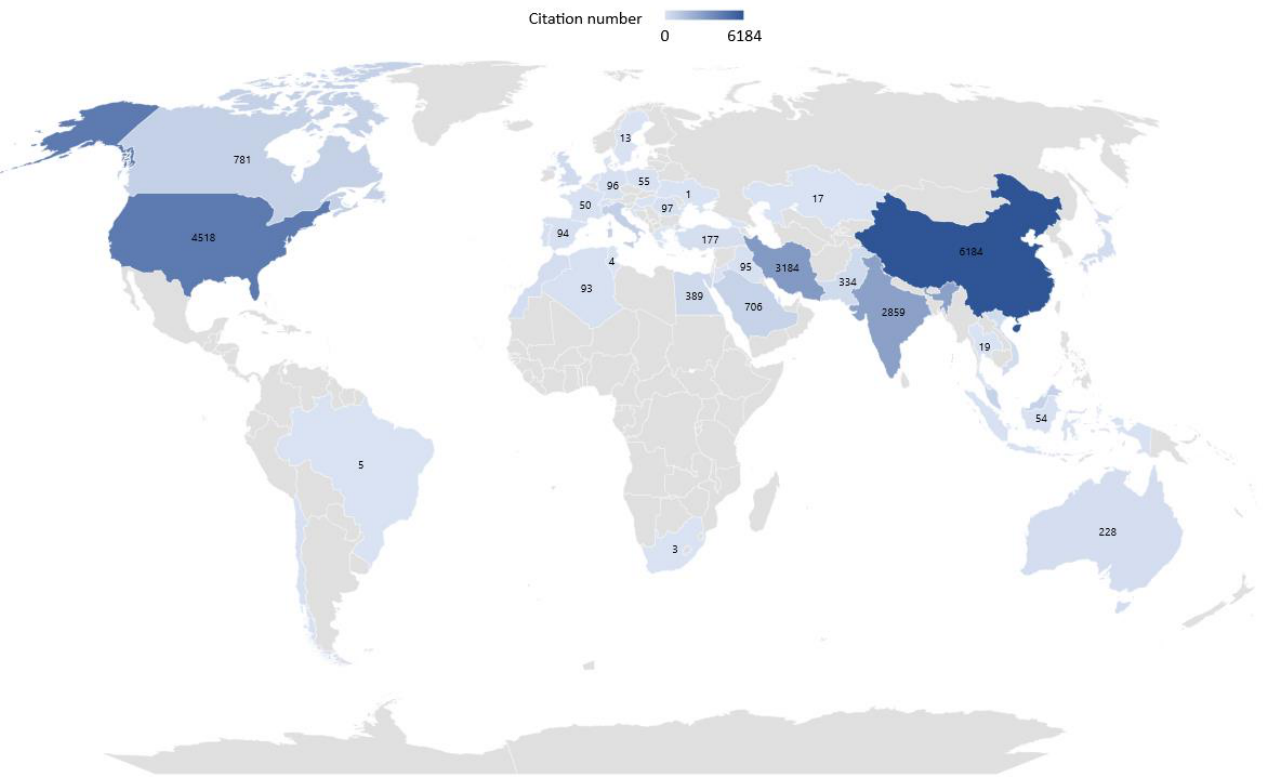
Figure 11. Most cited countries for research in TES using NePCM.